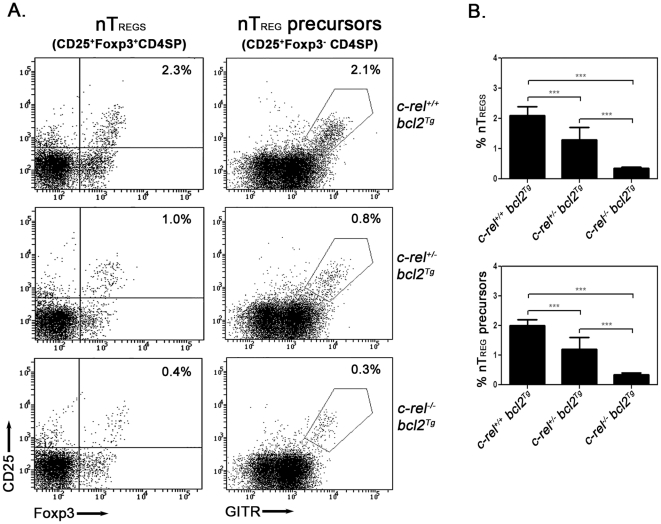
Bcl-2 transgene expression fails to rescue the deficit of nTreg precursors in c-Rel deficient mice.Thymocyte suspensions from c-rel+/+bcl-2Tg, c-rel+/−bcl-2Tg and c-rel−/−bcl-2Tg mice were fixed, permeabilized and stained with antibodies for CD4, CD8, CD25, GITR and Foxp3. Representative dot plots from one of three independent experiments are displayed with the percentage of cells in the relevant quadrants indicated. (A) Profiles of CD25 versus Foxp3 (gated on CD4 SP cells) and CD25 versus GITR (gated on Foxp3−CD4SP cells). Two mice of each genotype were analyzed in each experiment. (B) Percentages of thymic nTregs (CD25+Foxp3+CD4SP) and nTreg precursors (CD25+Foxp3−CD4SP) in c-rel+/+bcl-2Tg, c-rel+/−bcl-2Tg and c-rel−/−bcl-2Tg mice. The data represents the mean values (±SEM with ANOVA p value <0.0001) compiled from three independent experiments described in panel A.